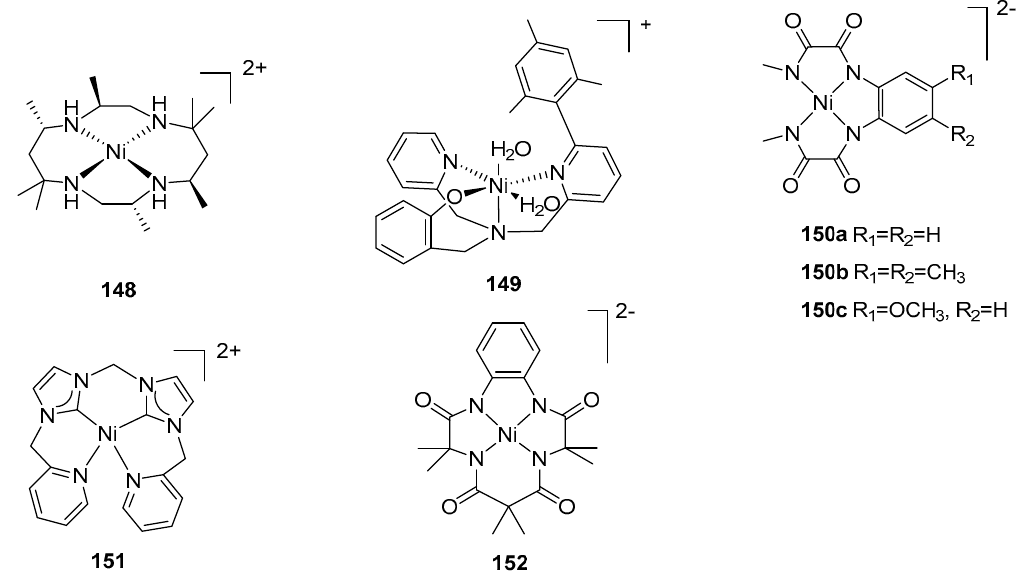
Figure 10. Selected cobalt complexes 141–152 for water oxidation: [Ni( meso -L)] 2+ ( 141 , L = 5,5,7,12,12,14 hexamethyl- Figure 10.